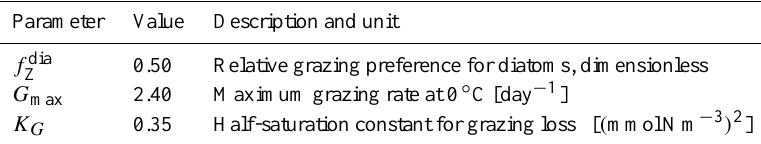
Table A9. Parameters for grazing.